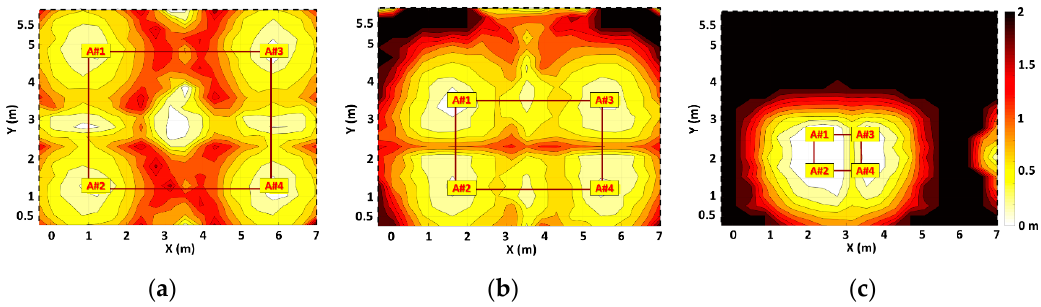
Figure 13. Simulated localization error distribution over room area for each mesh configuration: ( a ) large mesh; ( b ) medium mesh; ( c ) tiny mesh.